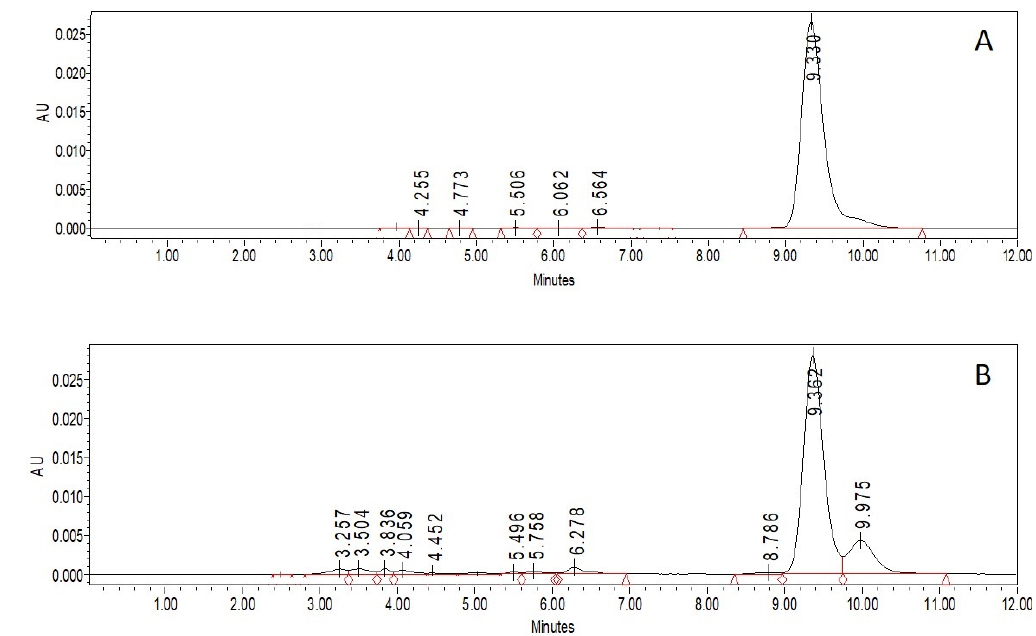
Figure 2. Chromatograms of pure CAR ( A ) and CAR extracted from CAR/HP-CD aggregates ( B ). CAR/HP-CD aggregates were prepared using 5% HP-CD in water, and CAR was dissolved in acetone. Table 2. The dependence of entrapped CAR content on CAR dissolution solvent.